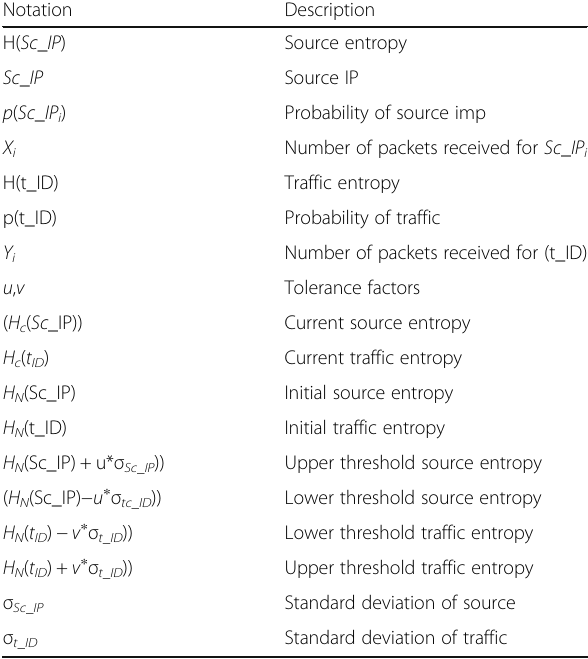
Table 1 Notations used in the methodology for various notations used in the proposed approach and